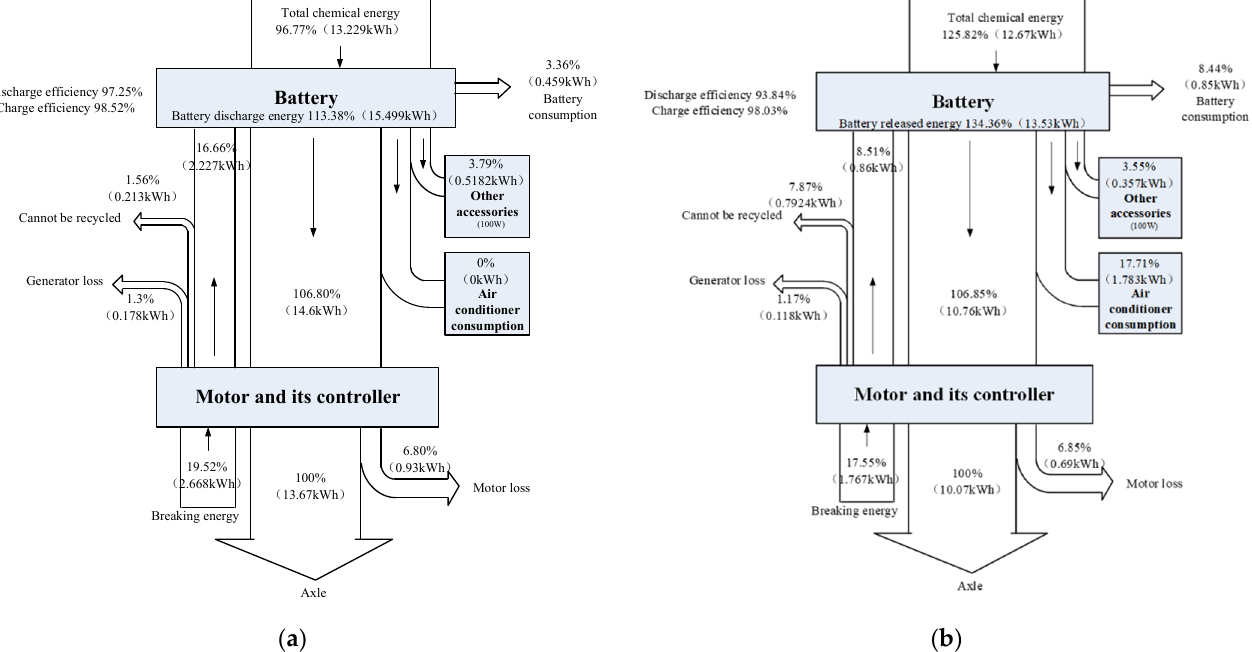
Figure 7. Energy float diagram under two conditions: ( a ) ambient temperature is 25 °C, battery pack initial temperature is 25 °C, and air conditioner is off; ( b ) ambient temperature is − 10 °C, ba tt ery pack initial temperature is − 10°C, and air conditioner is on and maintains the cabin at 16 °C.